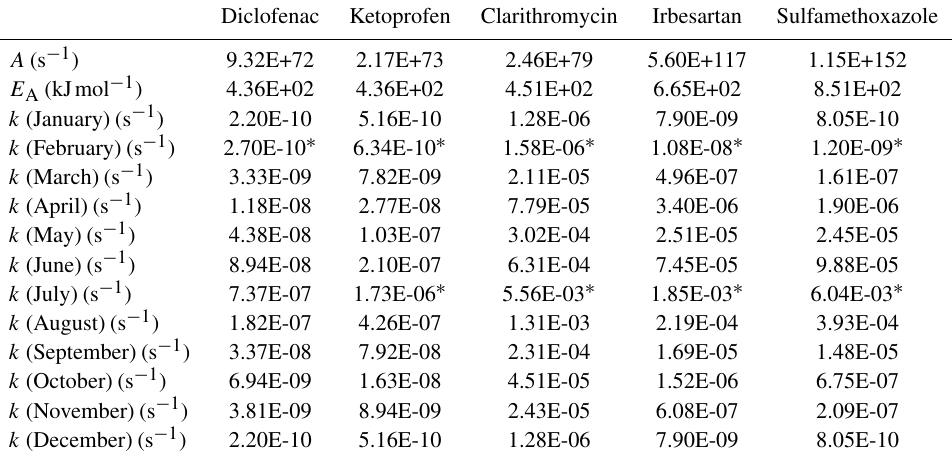
Table 5. Monthly decay rates ( k ( s − 1 ) ) of the five selected compounds, computed by using the Arrhenius law (Eq. 18) with the values of A( s − 1 ) and E A ( kJmol − 1 ) , obtained by inverting Eq. (18) with reference to the decay rate inferred from the observational data of February and July 2015 (first two